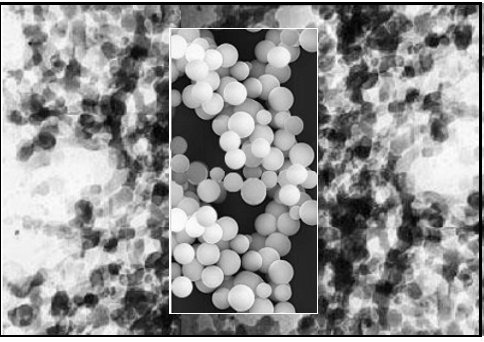
Figure 1. TEM image of silica aerogel